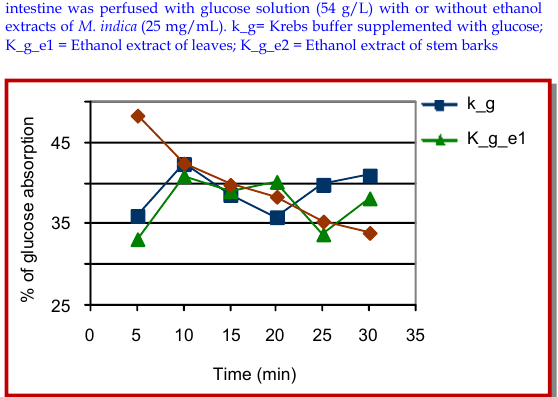
Figure 2: Effect of the M. indica on upper intestinal glucose absorp- tion on type 2 diabetic rats Results are presented as mean ± SD (n = 6). Rats were fasted for 36 hours and intestine was perfused with glucose solution (54 g/L) with or without ethanol extracts of M. indica (25 mg/mL). k_g = Krebs buffer supplemented with glu-